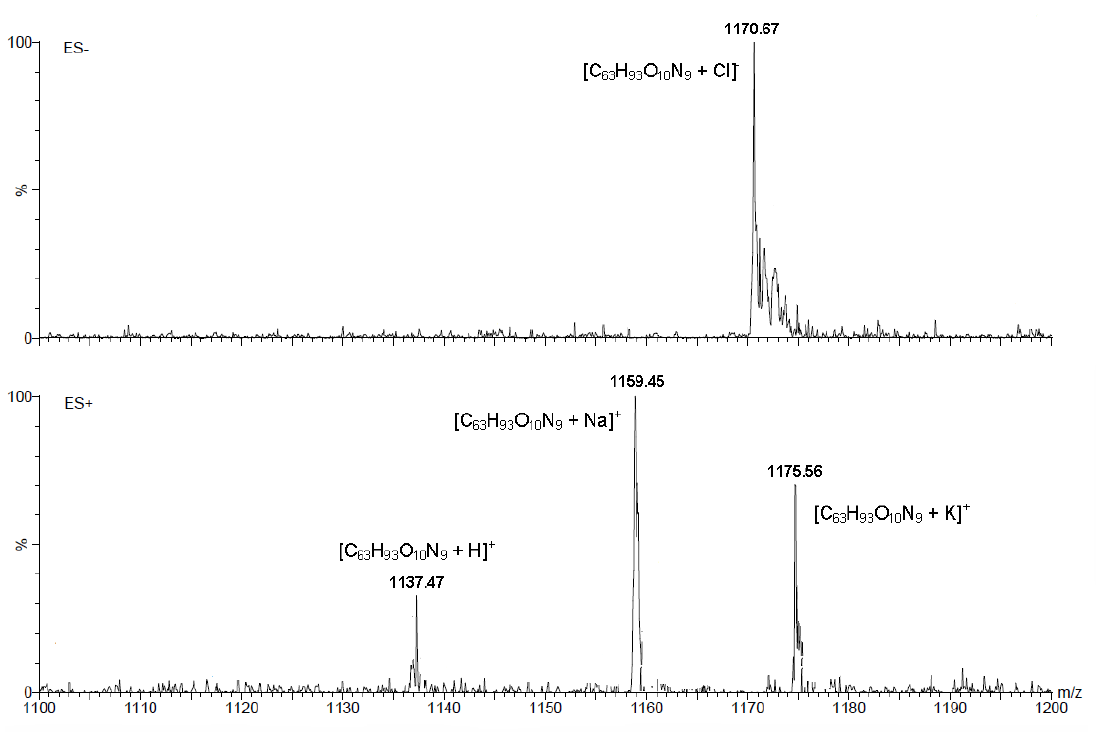
Figure 3. ESI-MS spectrum of conjugate 10